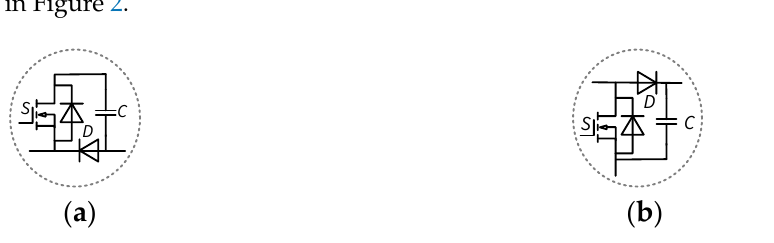
Figure 2. Two forms of the switch-capacitor cell. ( a ) common anode SCC. ( b ) common cathode SCC.